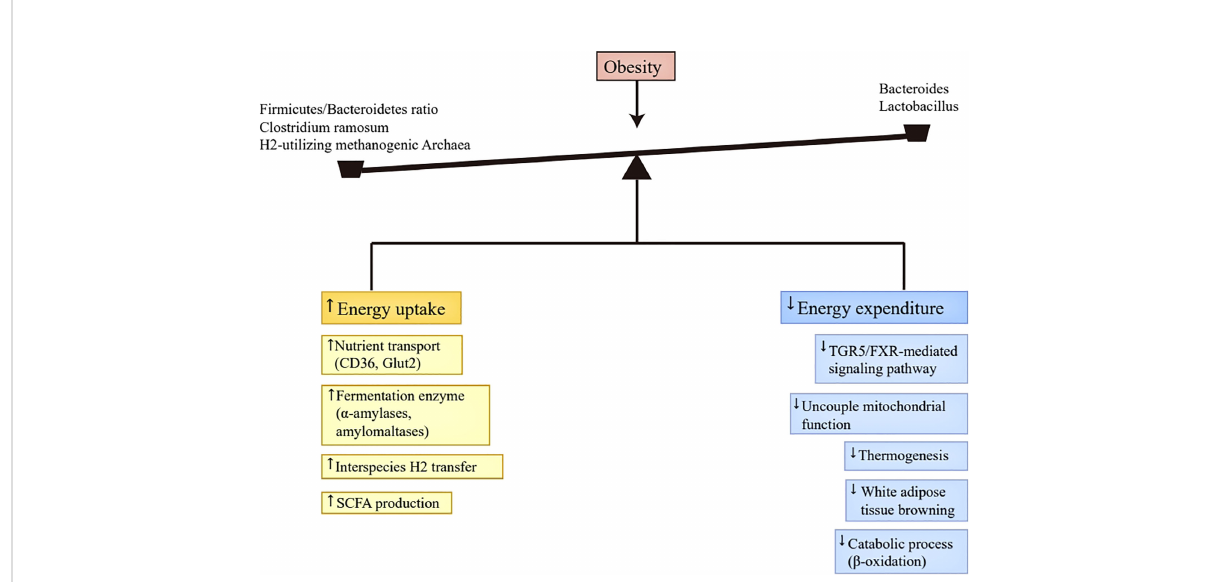
FIGURE 1 Energy homeostasis disruption. Abundant nutrient transporters (CD36, Glut2) and various primary fermentation enzymes ( a -amylases and amylomaltases) caused by altered gut microbiota in obesity improve the ef fi ciency of digestible energy uptake and promote monosaccharides and SCFAs production. Moreover, the production of SCFAs was also enhanced by the interspecies H2 transfer between bacteria and archaea. The produced monosaccharides and SCFAs in the gut tract can be absorbed by the host. The decrease of Bacteroides and Lactobacillus in obesity leads to the reduction of bile acids, which inactivates TGR5/FXR-mediated signaling pathway in brown adipose tissue, thus reducing uncouple mitochondrial function, thermogenesis, and white adipose tissue browning. Additionally, the presence of SCFAs suppresses FIAF secretion in the intestine, which then inhibits catabolic process, such as b -oxidation. Taken together, the altered gut microbiota in obesity results in more energy uptake and less energy expenditure, which contributes to the progression of obesity. SCFAs, short-chain fatty acids; TGR5, Takeda G protein-coupled receptor 5; FXR, Farnesoid X Receptor; FIAF, fasting-induced adipose